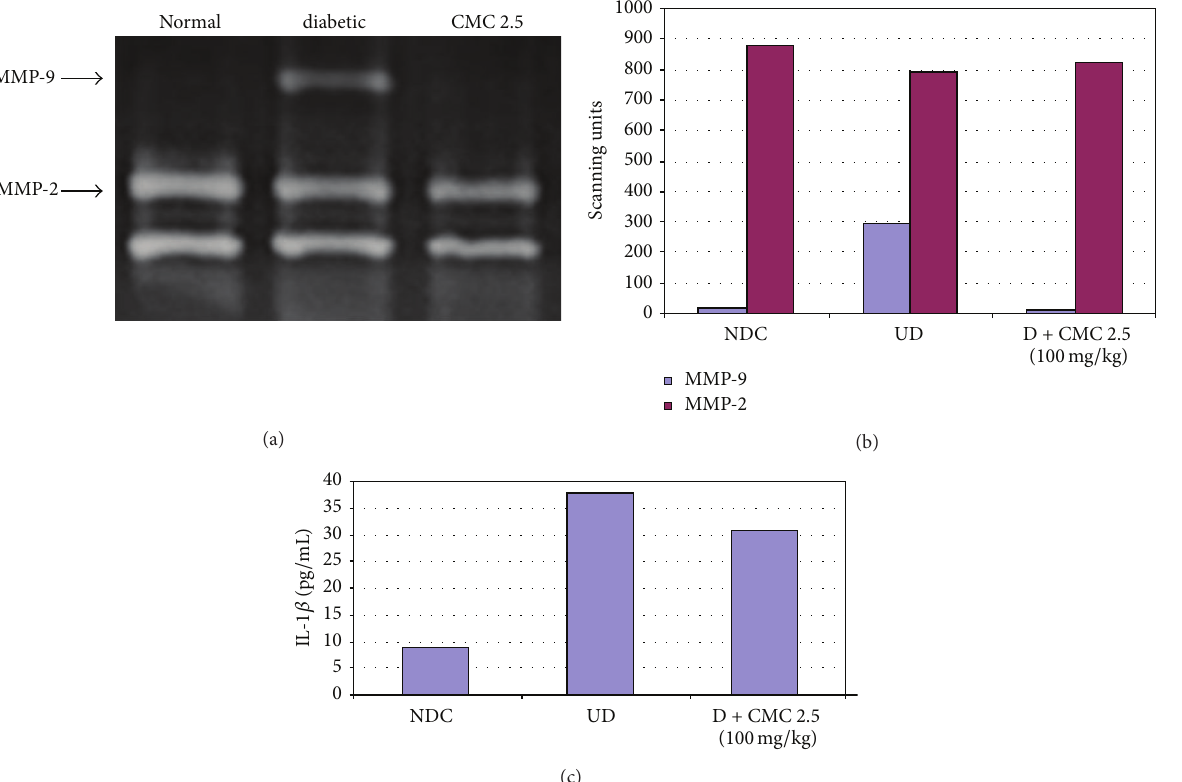
Figure 8: The effect of diabetes and orally administered CMC 2.5 on gingival MMPs (-2, -9) and IL-1 𝛽 . Gingival tissue from diabetic rats treated with vehicle or CMC 2.5 was obtained and pooled by group as described in Section 2, since insufficient gingival tissue is usually available for individual analysis. Gingival tissues were then extracted and aliquots of each gingival extract were measured for MMP-2 and MMP-9 by gelatin zymography and were scanned densitometrically to quantify gelatinase activity, and IL-1 𝛽 was measured by ELISA. NDC: nondiabetic control; UD: untreated diabetic.